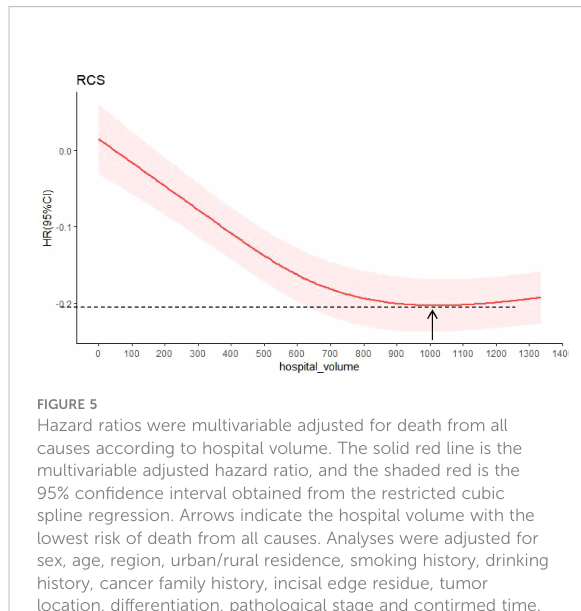
FIGURE 5 Hazard ratios were multivariable adjusted for death from all causes according to hospital volume. The solid red line is the multivariable adjusted hazard ratio, and the shaded red is the 95% con fi dence interval obtained from the restricted cubic spline regression. Arrows indicate the hospital volume with the lowest risk of death from all causes. Analyses were adjusted for sex, age, region, urban/rural residence, smoking history, drinking history, cancer family history, incisal edge residue, tumor location, differentiation, pathological stage and contirmed